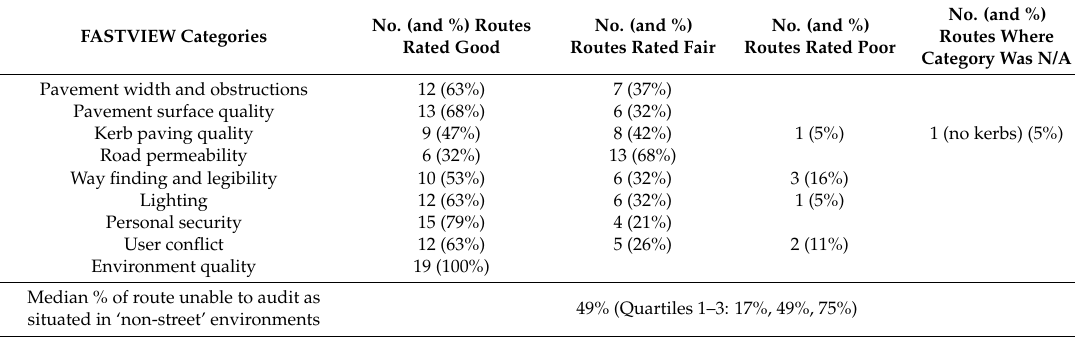
Table 2. Route walkability scores.